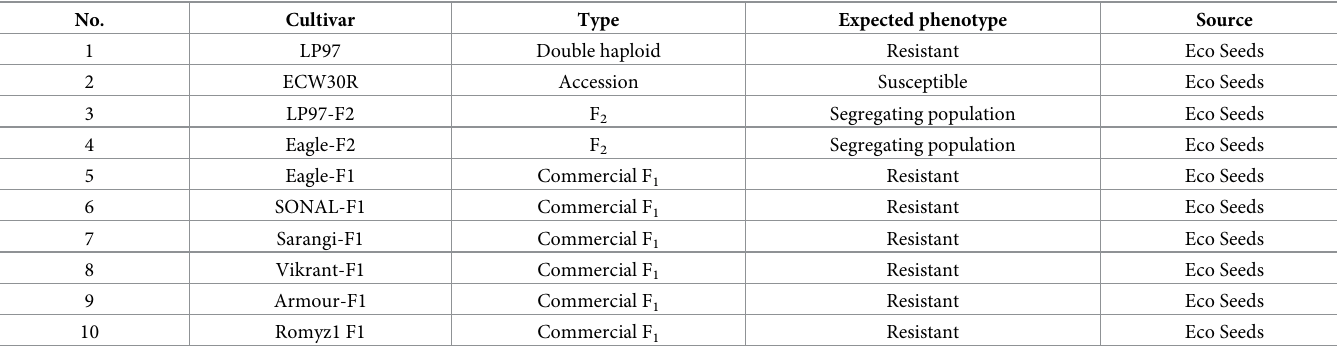
Table 1. Plant material used for mapping and marker